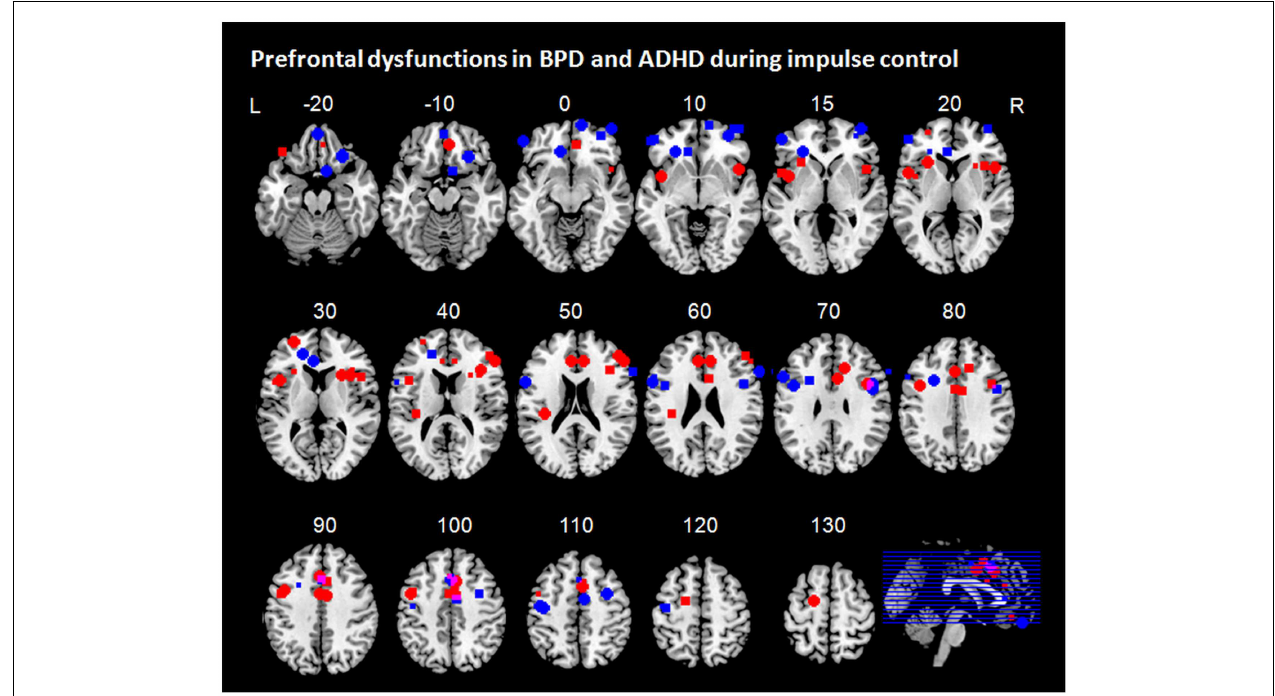
2011), Epstein et al. (2007), Hart et al. (2013), Holtmann et al. (2013), Jacob et al. (2013), Rubia et al. (2009b), Sebastian et al. (2012), Silbersweig et al. (2007),Wilbertz et al. (2012),Wingenfeld et al. (2009), andVöllm et al. (2007). Blue, prefrontal dysfunctions associated with impulse control in ADHD; red, prefrontal dysfunctions associated with impulse control in BPD; pink, overlap of ADHD and BPD. L = left; R =